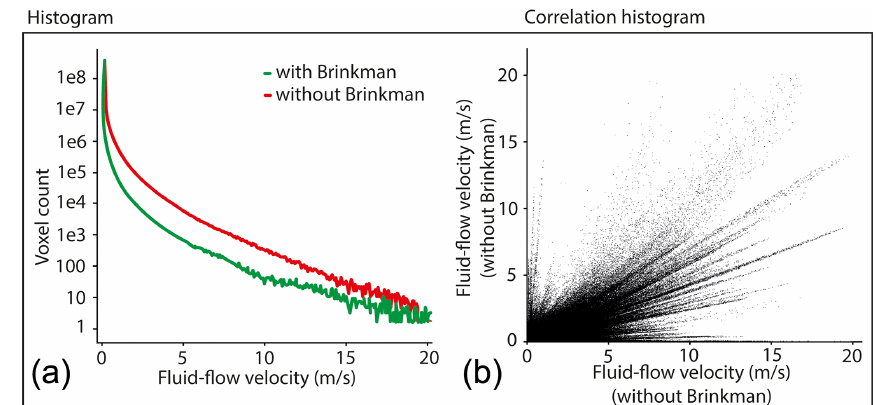
Figure 12. Comparison of unmodelled µXCT images and modelled microporous domain images (a) . Correlation histogram prior to and after the modelling that shows a decrease in the main fluid-flow velocities, while few velocities after the modelling were increased with a wide spread of distribution (b)